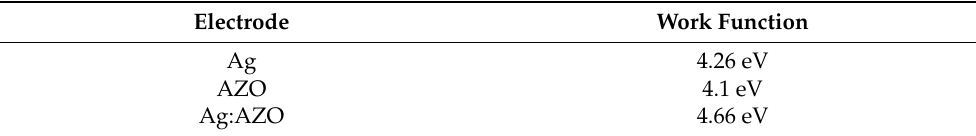
Table 5. Work function of electrodes measured by ultraviolet photoelectron spectroscopy.